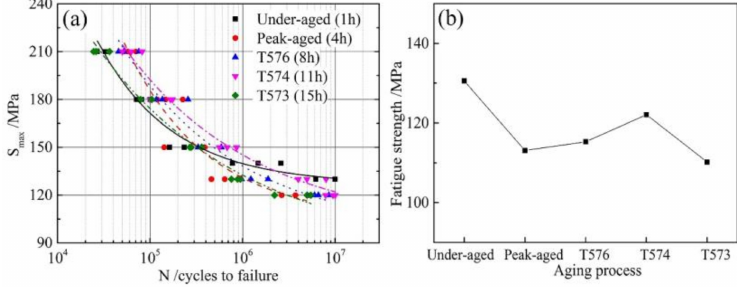
Figure 8. ( a ) S-N curves and ( b ) Fatigue strength at 10 7 cycles of di ff erent aged